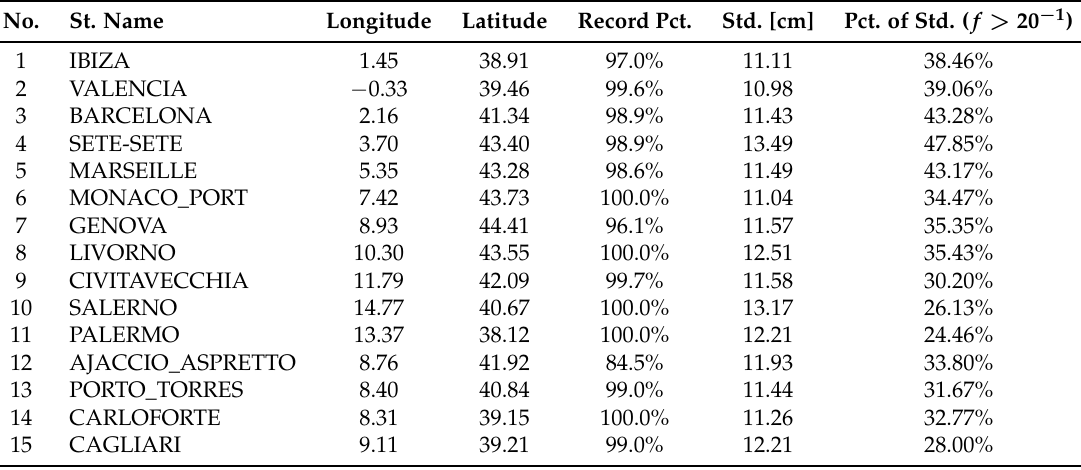
Table 1. Information of selected tide gauge stations. The last column indicates the percentage (Pct.) of high-frequency motion signals standard deviation